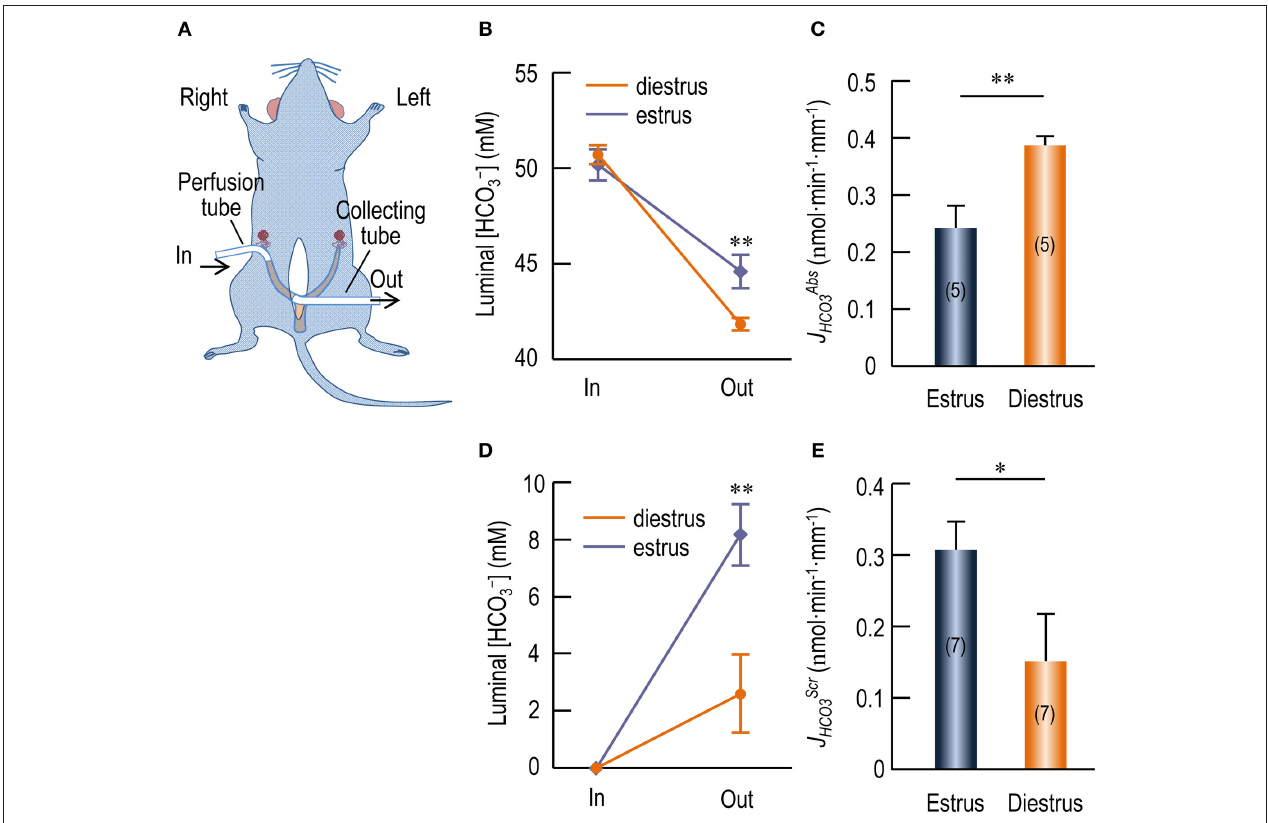
FIGURE 8 | In vivo perfusion study showing HCO − 3 transport by endometrial epithelium of rat uterus. (A) Diagram for in vivo perfusion of rat uterus. For perfusate delivery, a perfusion tube was cannulated at the distal end of the right uterus horn. For sample collection, a collecting tube was cannulated at the proximal end of the right uterus horn. (B) Changes in [HCO − 3 ] of the luminal perfusate in rat uteri when perfused with Ringers’ solution containing 5% CO 2 /50mM HCO − 3 . (C) Rate of HCO − 3 reabsorption ( J HCO3 Abs ) by endometrial epithelium at estrus and diestrus. (D) Changes in [HCO − 3 ] of the luminal perfusate in rat uteri when perfused with nominally HCO − 3 -free HEPES solution. (E) Rate of HCO − 3 secretion ( J HCO3 Scr ) by endometrial epithelium at estrus and diestrus. In: Influent fluid; Out: Effluent fluid. Stars in B,D indicate significance between estrus and diestrus. Student’s t -test was performed for statistical comparison between estrus and diestrus. * p < 0.05; ** p <